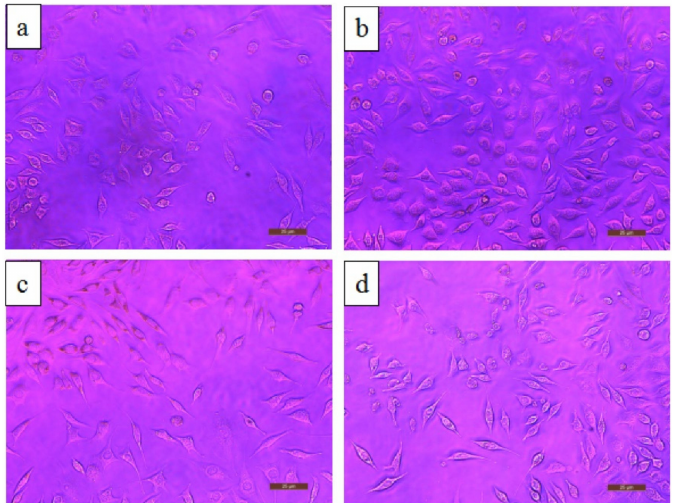
Figure 9. Optical micrograph of L-929 cells cultured in 100% extraction mediums for 72 h ( a ) ZK61, ( b ) ZK61/5 β -TCP, ( c ) ZK61/10 β -TCP and ( d ) ZK61/15 β -TCP composite